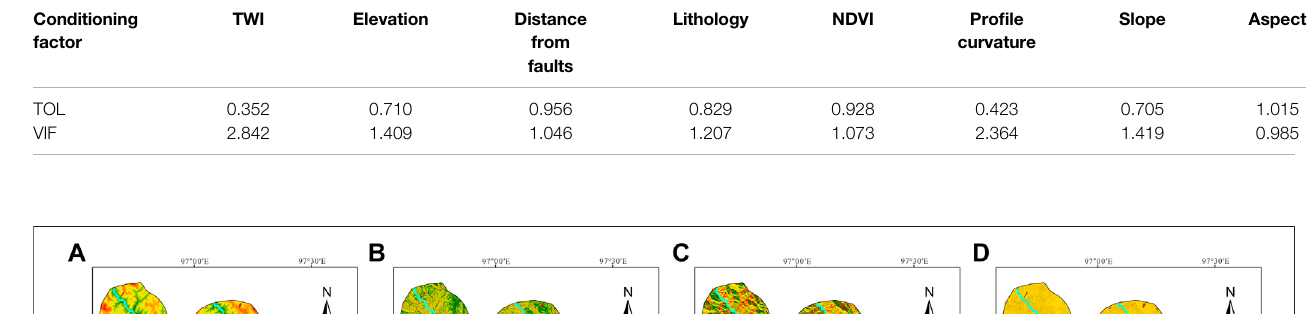
TABLE 1 | Diagnosis results of Multicollinearity among landslide conditioning factors. Conditioning factor TOL